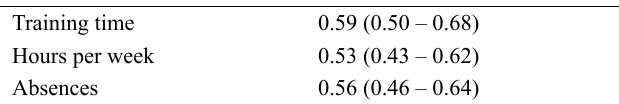
Table 3. Correlation between the answers on training time, hours per week, and reported absences in the prospective and retrospective study designs